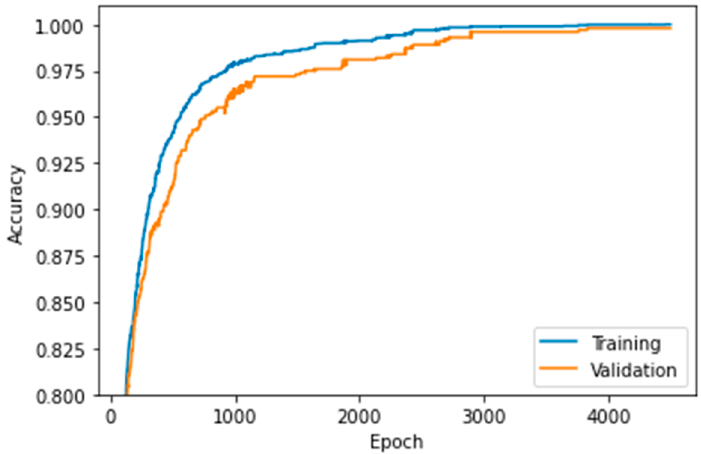
Figure 11. Accuracy vs. epochs for training and validation data with LR = 2.95 × 10 − 5 .